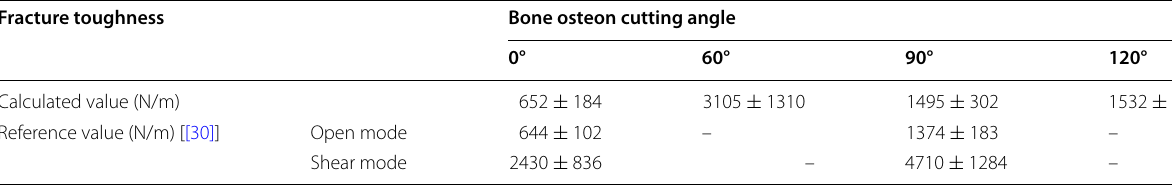
mainly applies in the bone osteon to produce the main crack (Figure 4(c)). On the other hand, the vertical cut- ting force makes the cortical bone to produce a crack along the cement line with a weakest strength. So the grainy chips are generated (Figure 14(e)). The experi- mental result showed that the chip morphology in Table 3 Fracture toughness value Fracture